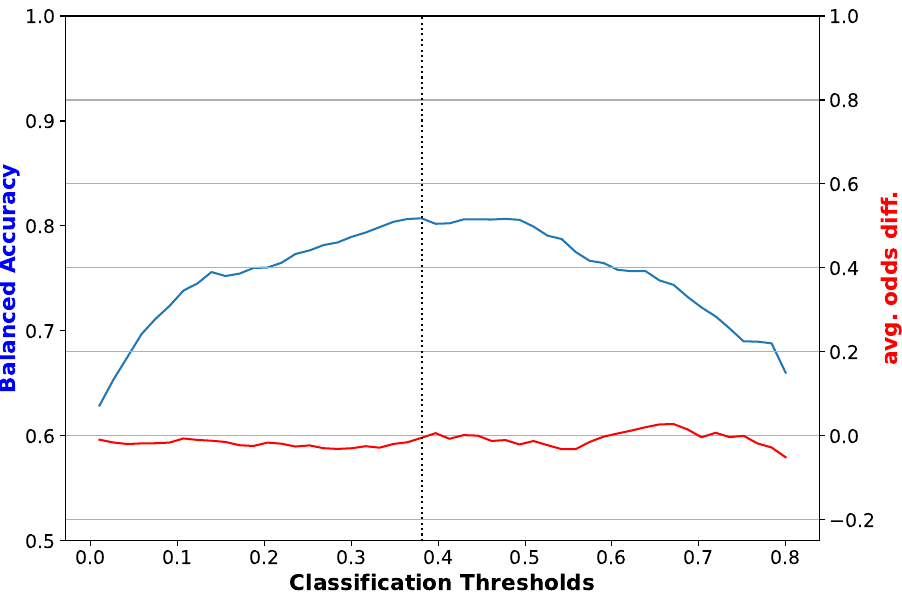
Figure 7. Balanced accuracy and average odds difference versus classification threshold for a logistic regression classifier with prejudice remover. The dotted vertical line is the threshold that maximizes balanced accuracy. The plot shown corresponds to one of the folds of